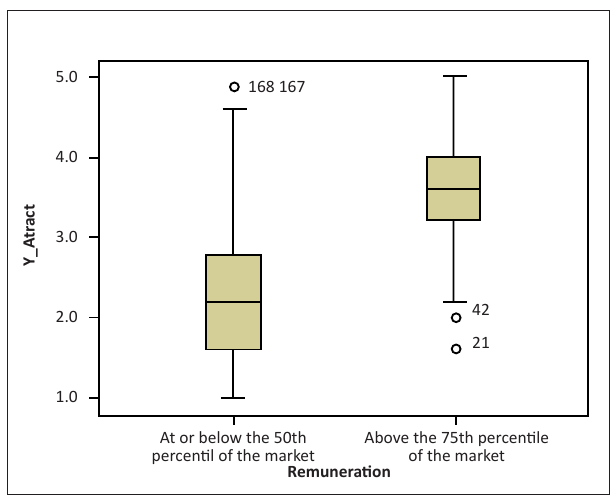
FIGURE 4: Box plot of a reward package consisting of remuneration and benefits.